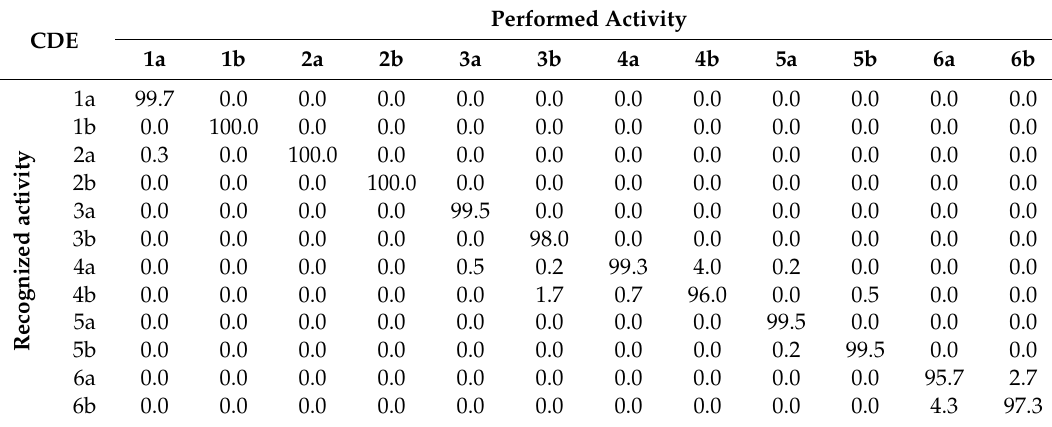
Table A9. Matrix of recognition errors (in %) of 12 motor activities 1a ÷ 6b in test set for all volunteers together for sensor